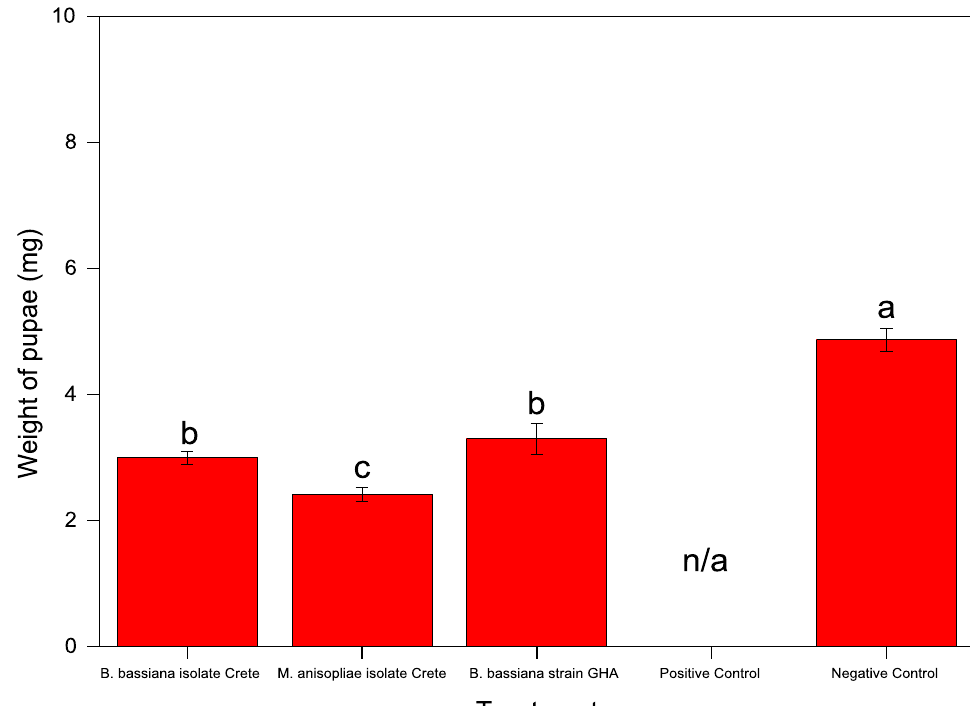
Fig. 4 Means ( se) of pupal weight of larvae developed in fungi‑free (control) plants and plants colonized by Beauveria bassiana isolate Crete and ± Metarhizium anisopliae isolate Crete and B. bassiana strain GHA after 15 DPI* (days per irrigation). Means of the same column followed by the same letter are non‑significantly different (HSD, p <